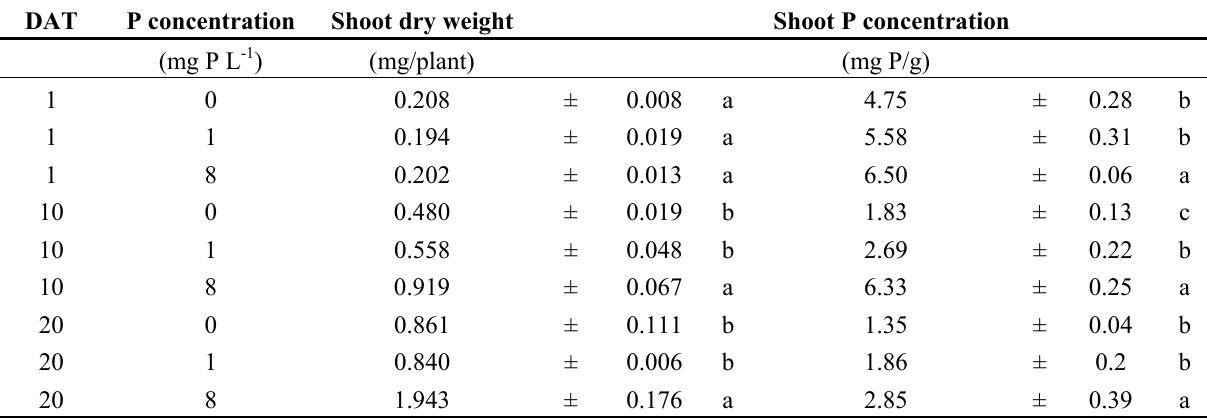
Table 1. Shoot dry weights and shoot P concentrations of common bean plants grown in culture solution at three P concentrations, 1, 10 and 20 days after transplanting (DAT). The means ± standard error of six biological replicates are shown. Means followed by the same letter are not significantly different ( p < 0.05) by the Tukey